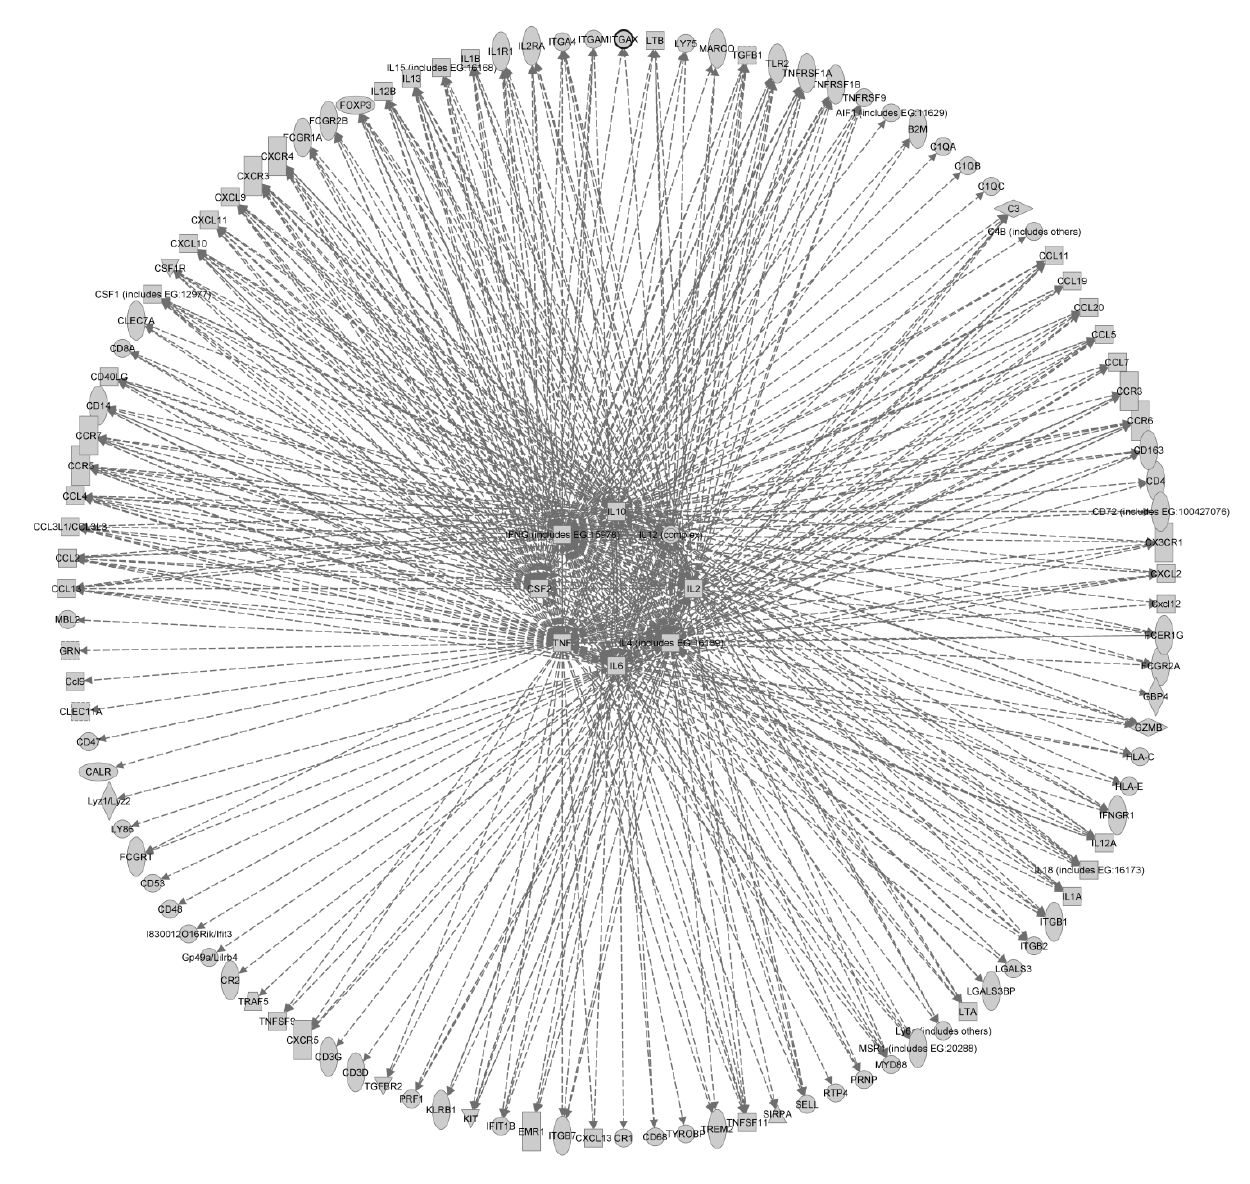
Figure 3. Wheel network diagram showing the overlap of the major upstream regulators of genes implicated in prion pathogenesis. The network was generated through the use of IPA (Ingenuity® Systems,